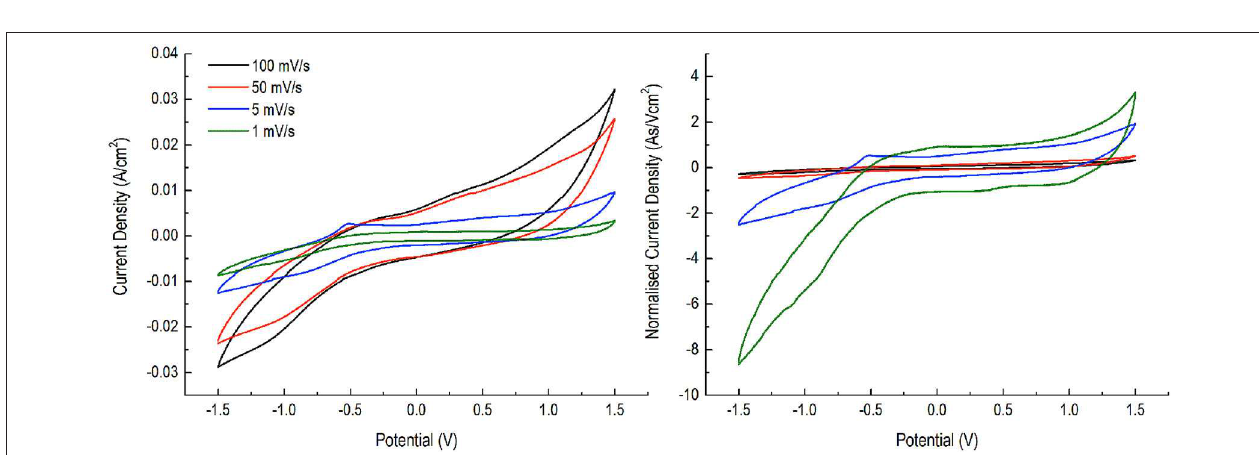
FIGURE 5 | CV analysis of NDRGO-Mo-Li-2S at 1, 5, 50, 100 mV/s and normalized current density (As/Vcm 2